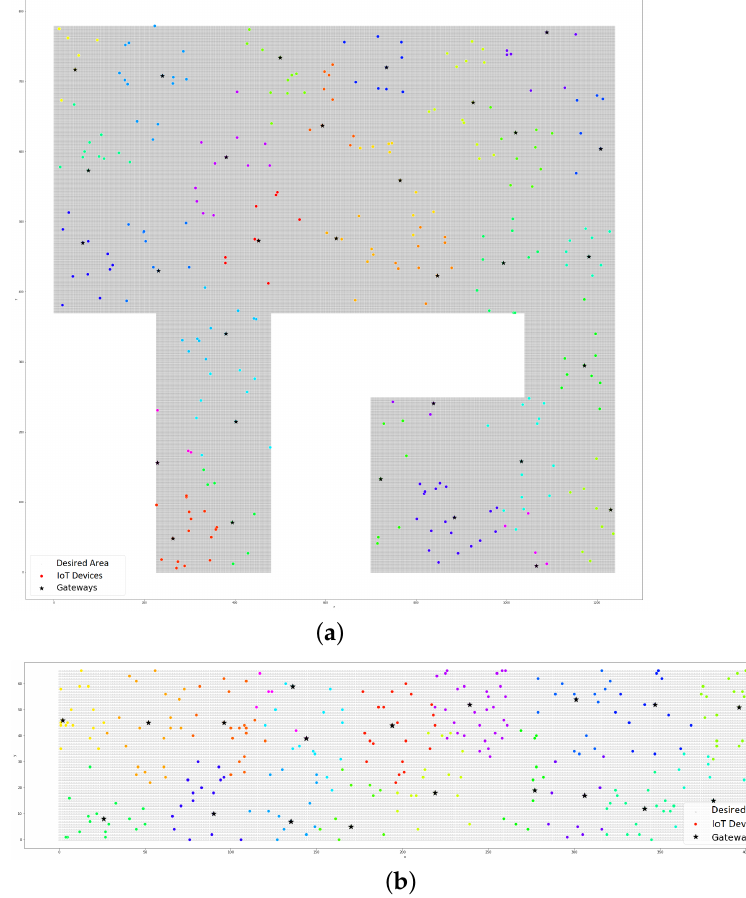
Figure 7. The plots of the devices and their gateways (Wi-Fi technology): ( a ) the Samambaia Campus with 300 devices (outdoor environment); ( b ) the academic blocks with 300 devices (indoor